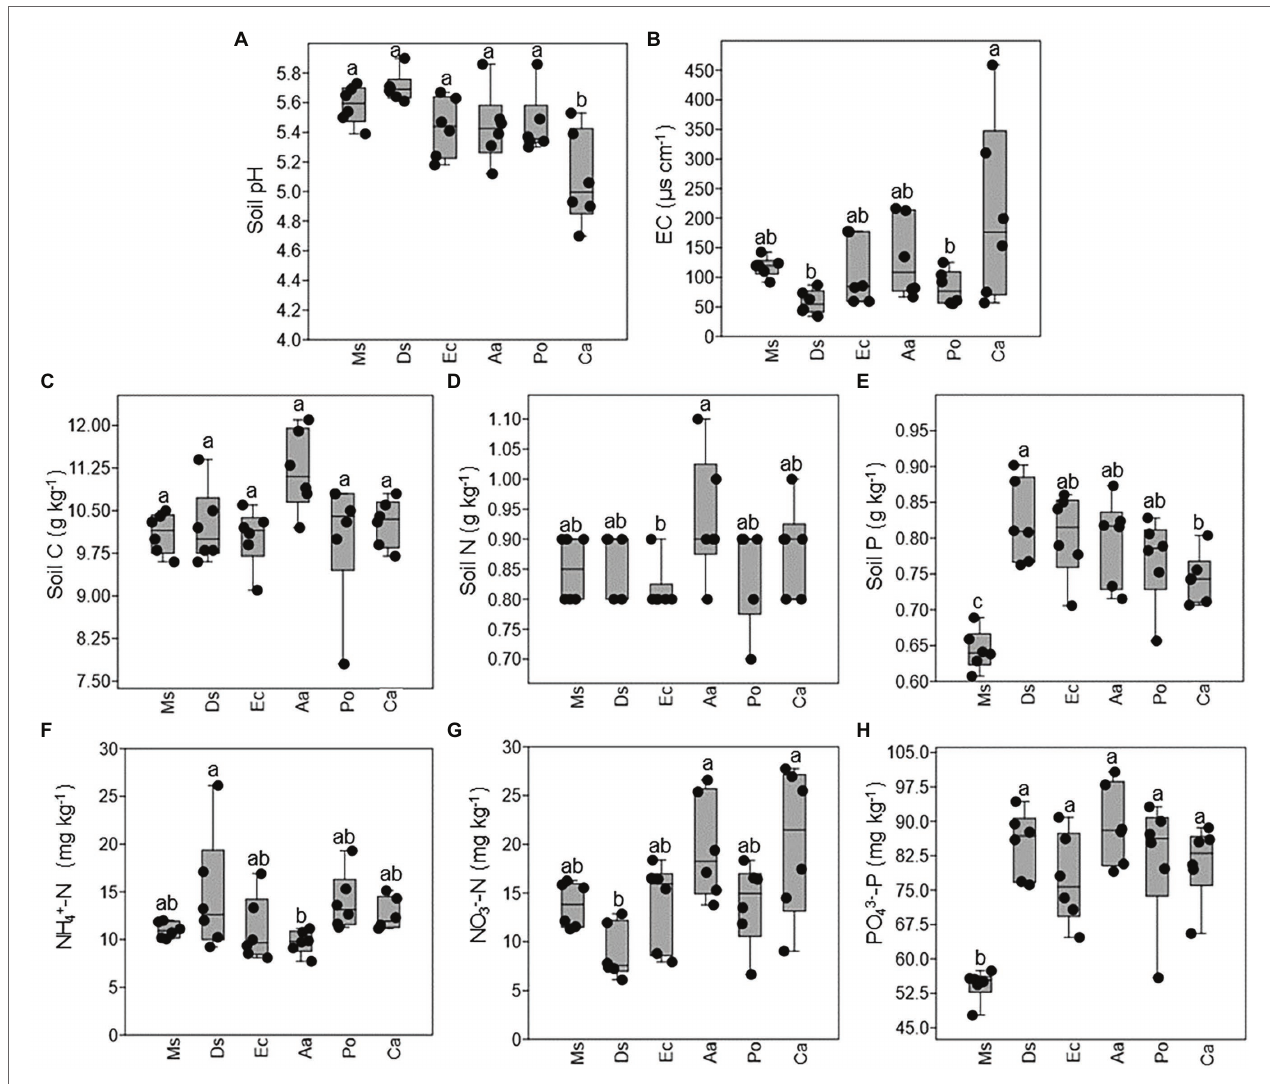
FIGURE 2 | Changes in the chemical properties of rhizosphere soil collected from M. sativa , D. sanguinalis , E. crusgalli , A australis , P . oleracea , and C. album . Values followed by different letters indicate significant differences ( p < 0.05) according to Tukey’s pairwise test (Soil C: soil carbon; Soil N: soil nitrogen; Soil P: soil